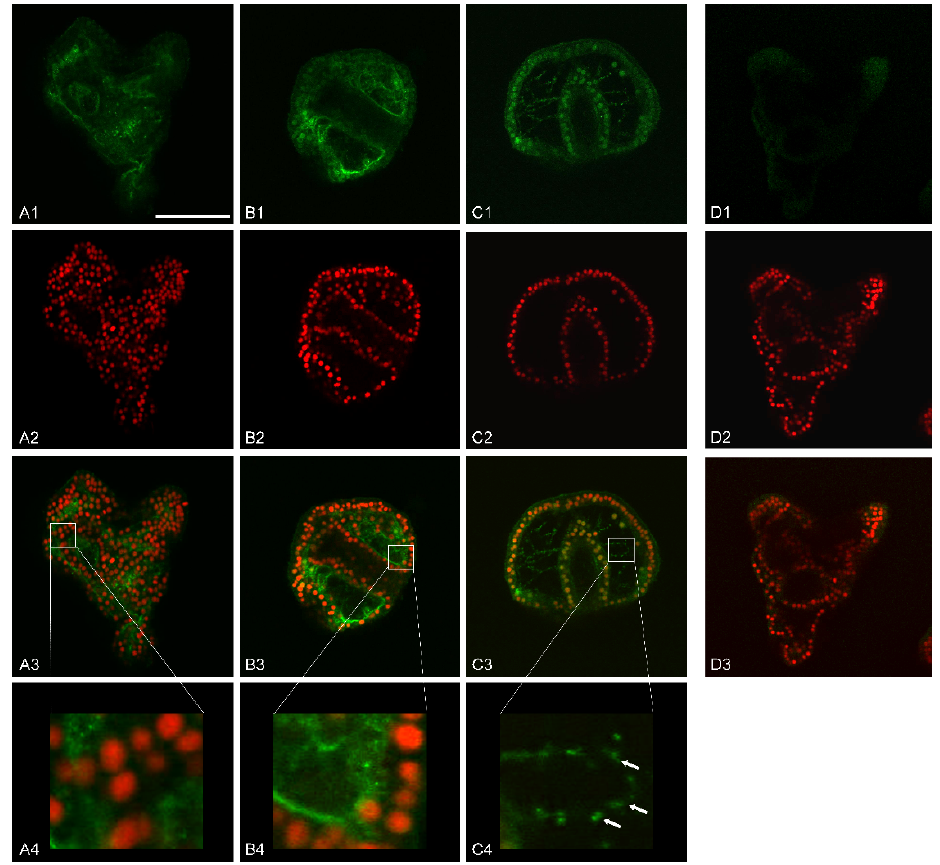
Figure 6. Immunolocalization analysis of MMP-14-like protease in whole mount embryos. Shown are representative confocal microscopy images of equatorial optical sections of embryos at 36 h of development/treatment. ( A1 , B1 , C1 ) MMP-14-like protein detection; ( A2,B2,C2,D2 ) nuclei counter- staining with propidium iodide (PI); ( A3 , B3 , C3 , D3 ) merge of green (MMP-14) and red (PI) signals. ( A1 – A3 ) Control embryo; ( D1 ) negative control with only the secondary antibody; ( B1 – B3 ) 1 mM V-treated embryo; ( C1 – C3 ) 500 µM V-treated embryo. ( A4 , B4 , C4 ) Higher magnification of a section of ( A3 ) control, ( B3 ) 1 mM V-treated, and ( C3 ) 500 µM V-treated embryo, respectively. White arrows indicate the localization of MMP-14-like in filopodia. Scale bar = 45 µm.